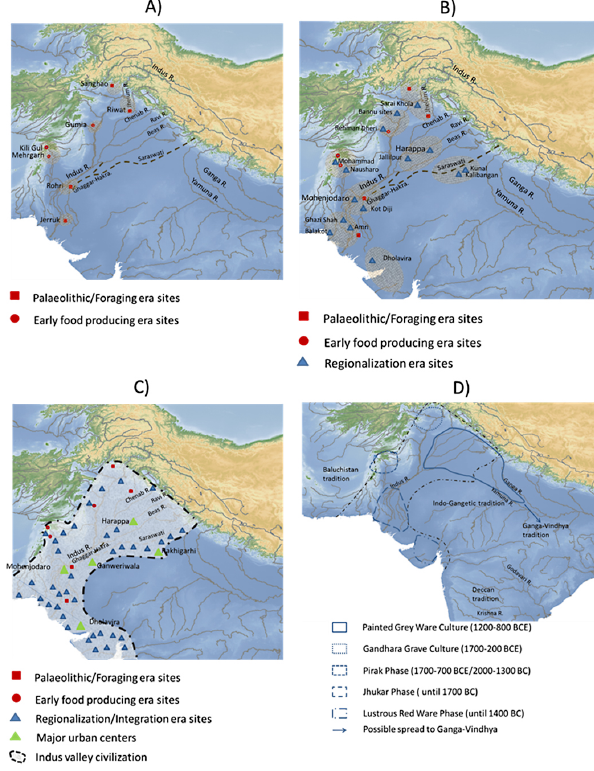
Fig. 5. The chronology of the Indus Valley Tradition. Compiled from Kenoyer (2008,